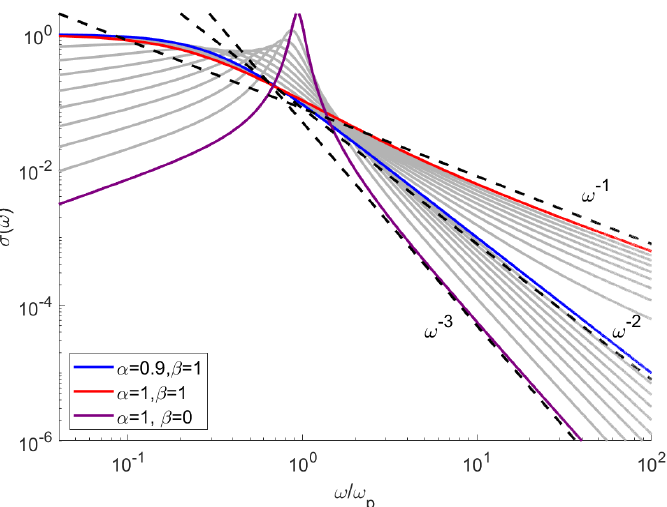
Figure 4. The electric conductivity as a function of frequency, calculated for various values of α and β .